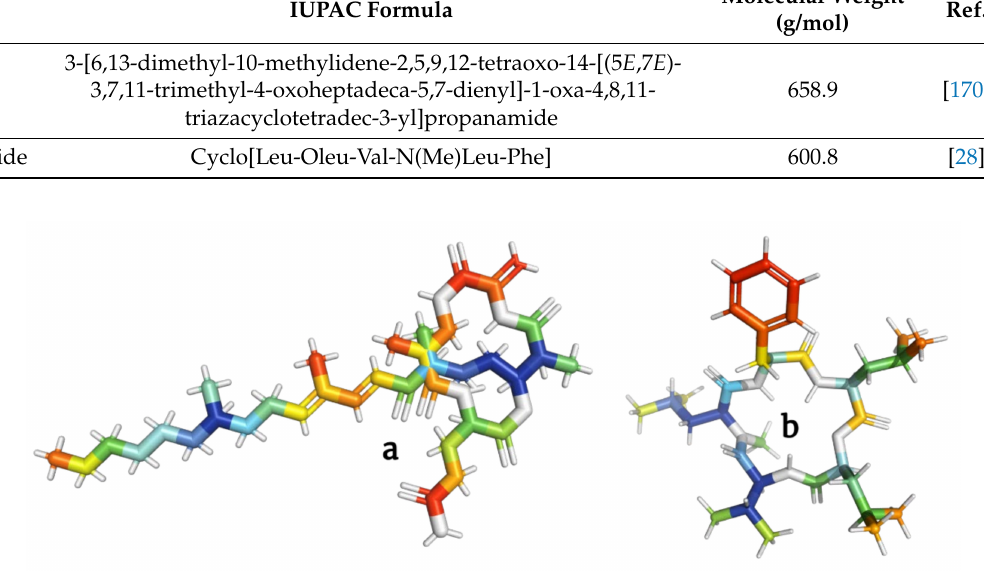
Figure 8. Models of fusaristatin A ( a ) and neo-N-methylsansalvamide ( b ) depsipeptides targeting topoisomerases in tumor